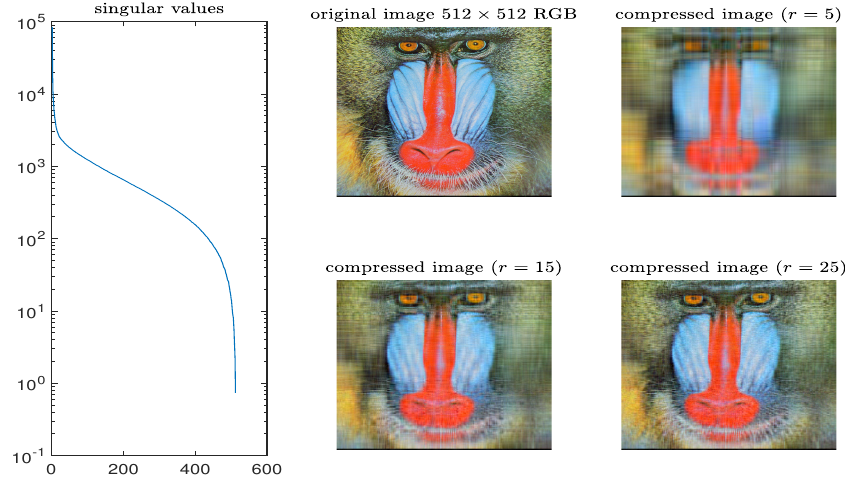
Figure 1. Image compression.